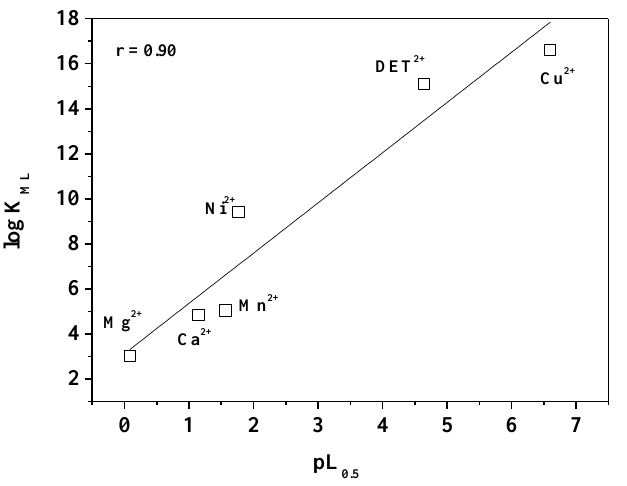
Figure 17. Relationship between the value log K ML value of some M 2+ metal/dopamine system vs. pL 0 . 5 . Data refer to I = 0.15 mol dm −3 , T = 298.15 K and pH = 7.4 (for pL 0 . 5 values).